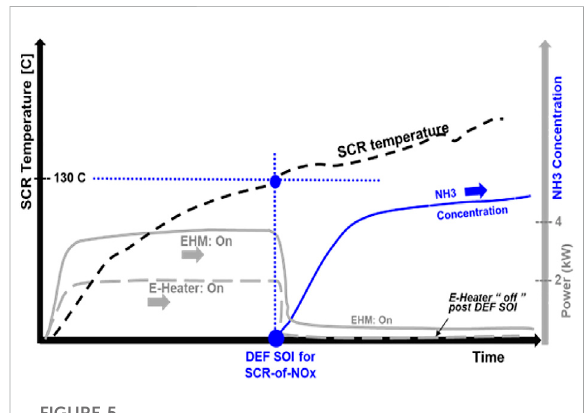
FIGURE 5 Example of the EHM system operation during a cold